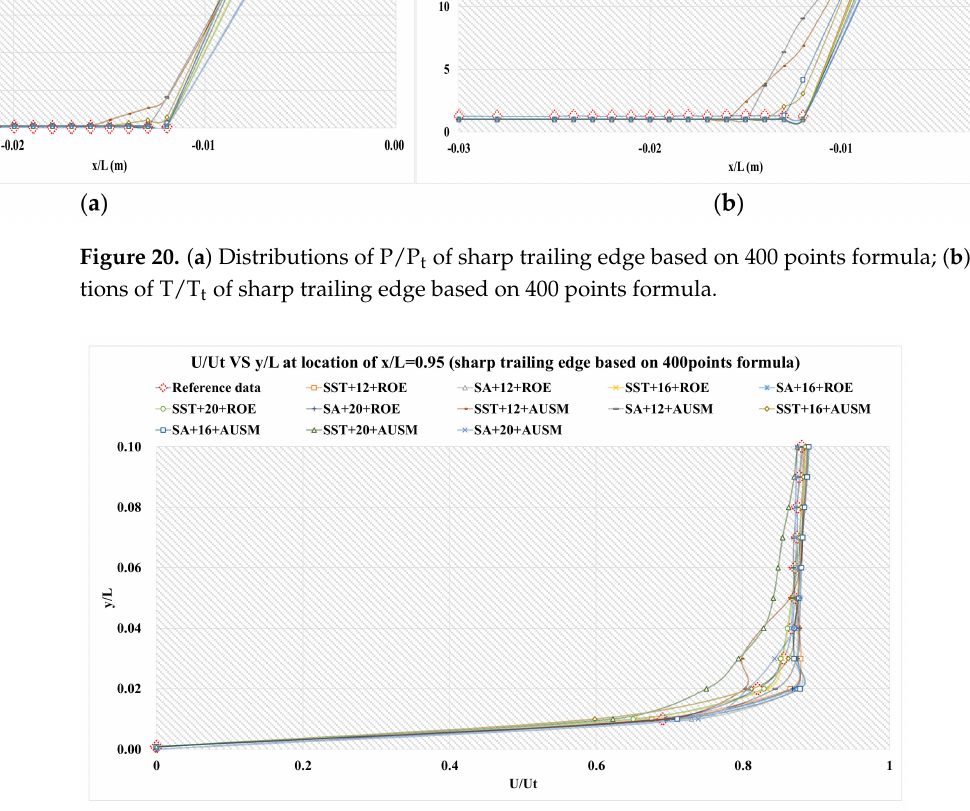
Figure 21. Distributions of U/U t of the sharp trailing edge based on 400 points formula at location of x/L = 0.95. Table 17. The mean error ratios of P/P t , T/T t , and U/U t of the sharp trailing edge based on 400